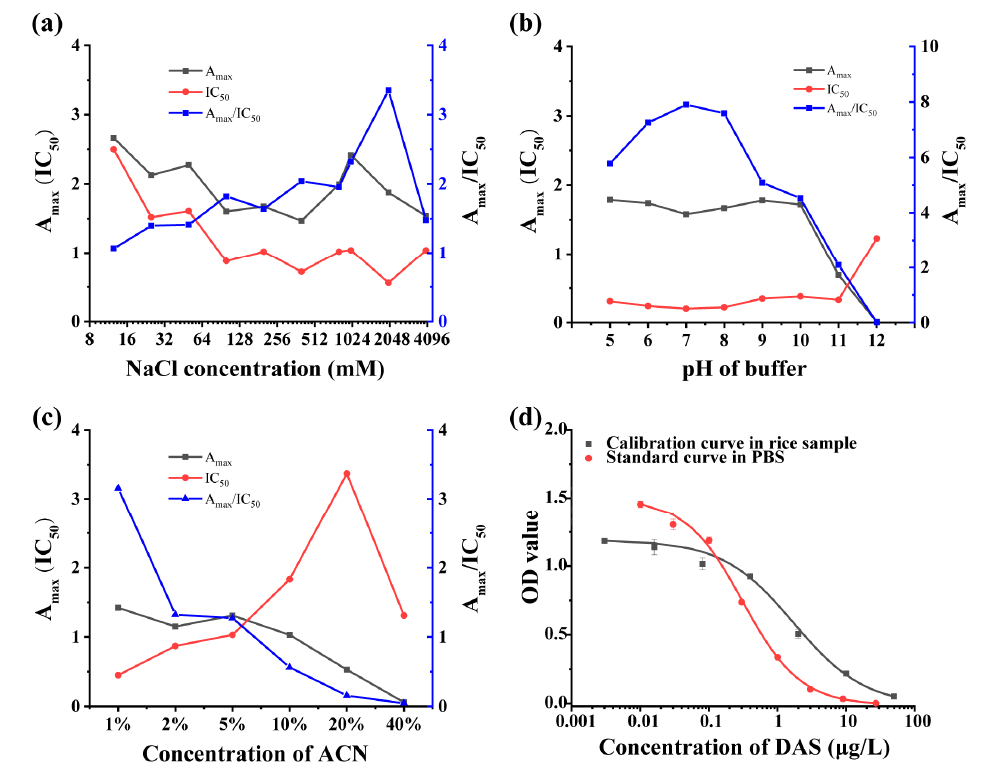
Figure 2. Optimization of physicochemical parameters. ( a ) NaCl concentration, ( b ) pH value, and ( c ) concentration of ACN on the ic-ELISA and the calibration curves assessed by the ic-ELISA ( n = 3). ( d ) Standard curve of ic-ELISA based on mAb 8A9 for DAS in PBS buffer and calibration curve in the diluted rice sample ( n = 3). Table 1. Reported antibodies for determination of DAS.